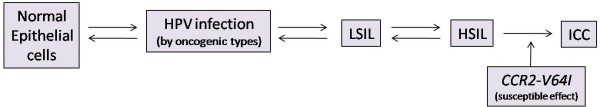
A schematic diagram showing the susceptible effect of CCR2-64I variant during development of ICC.